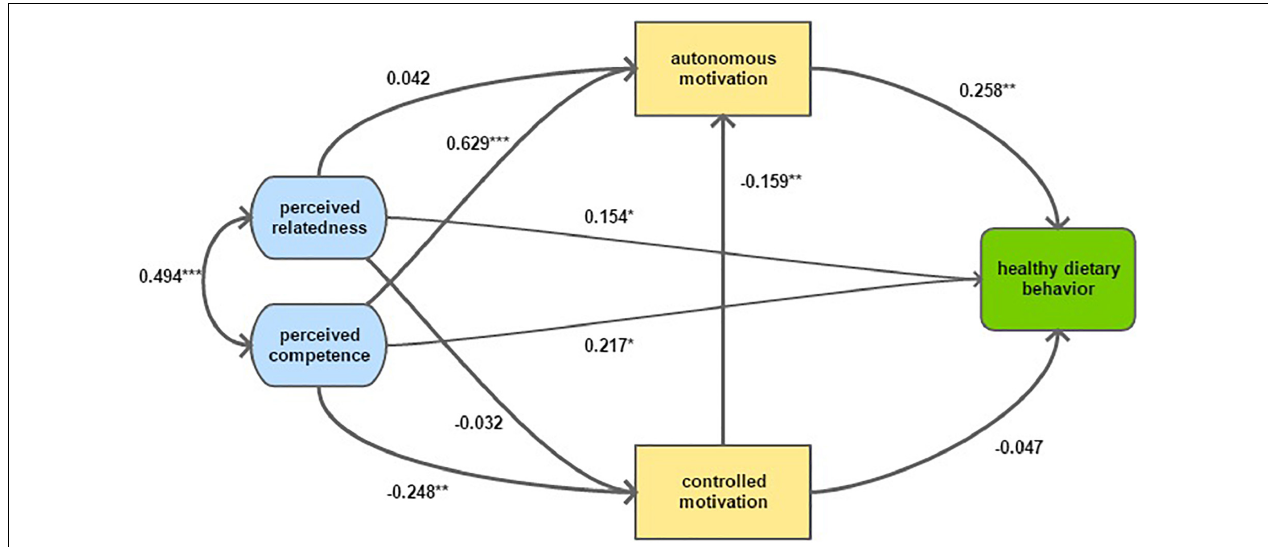
FIGURE 2 | Structural model displaying direct effects between motivational constructs and dietary behavior. Parameter estimates are fully standardized. * p -value < 0.05; ** p -value < 0.01; *** p -value < 0.005.